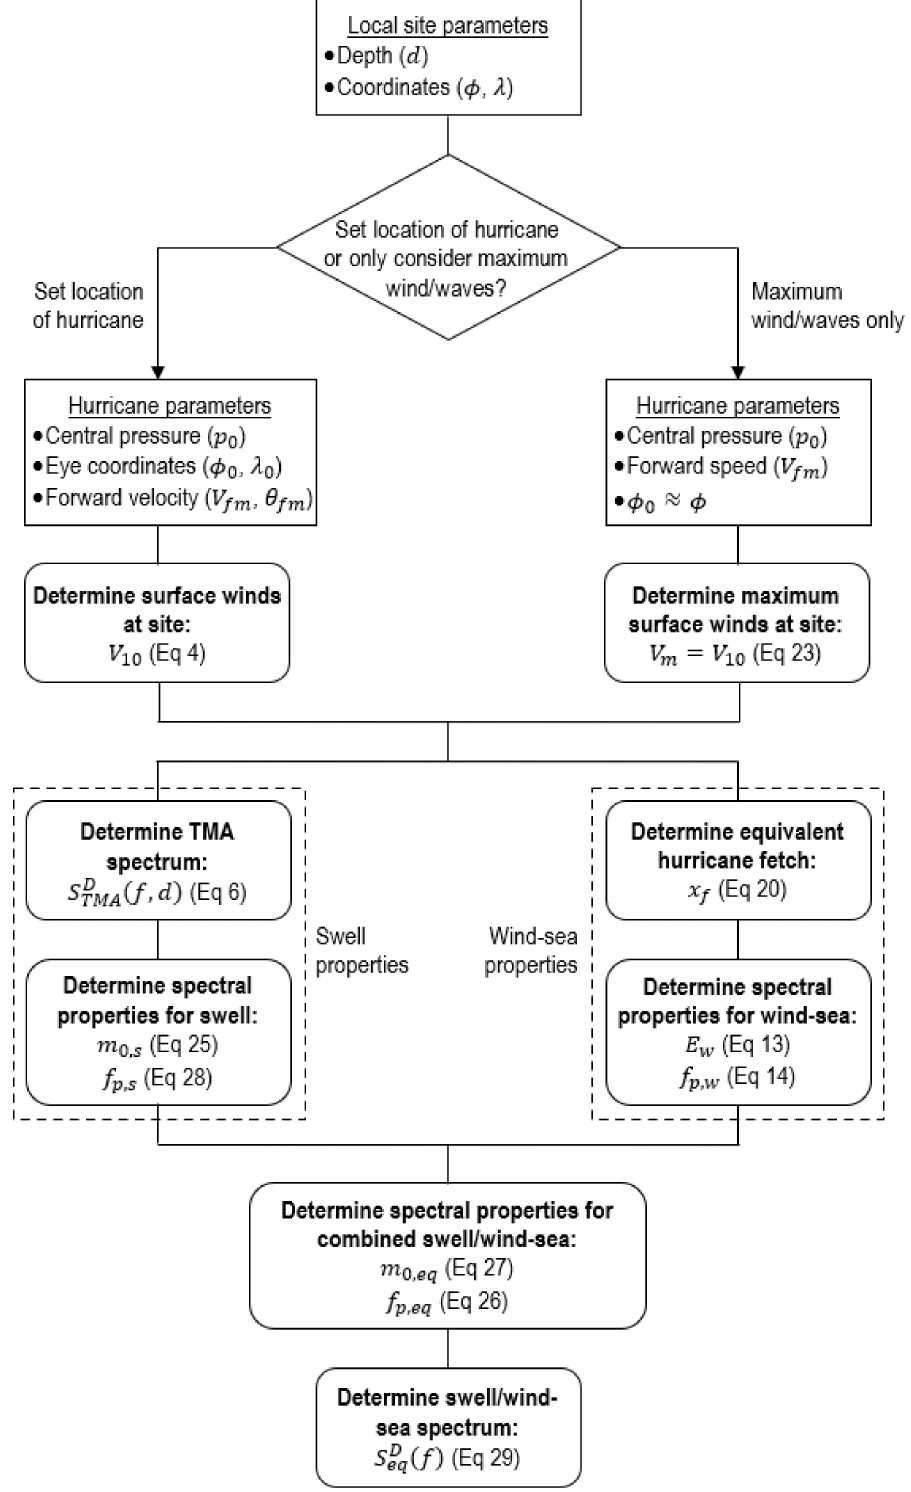
Figure 3. Flowchart summarizing the parametric model for the determination of combined shallow water swell/wind-sea spectra associated with